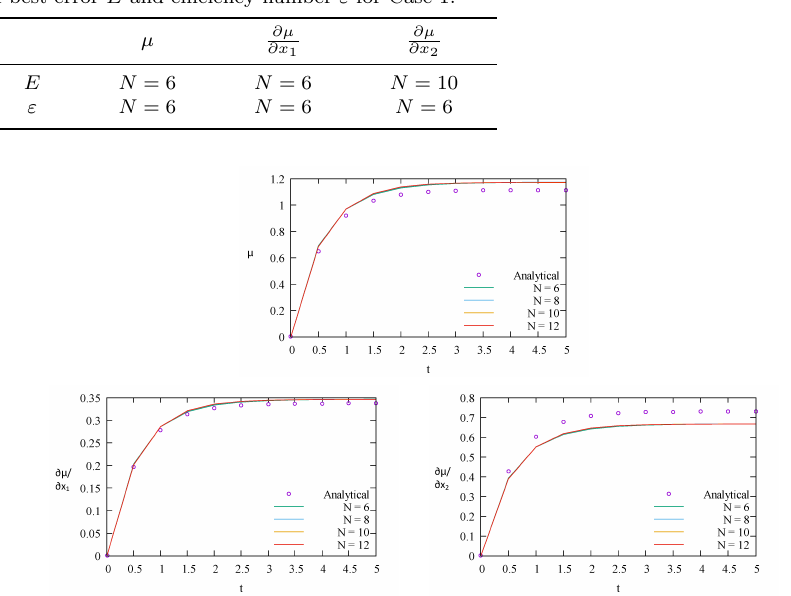
Table 3. The optimized value of N for obtaining the numerical solutions µ,∂µ/∂x 1 ,∂µ/∂x 2 of best error E and efficiency number ε for Case 1.